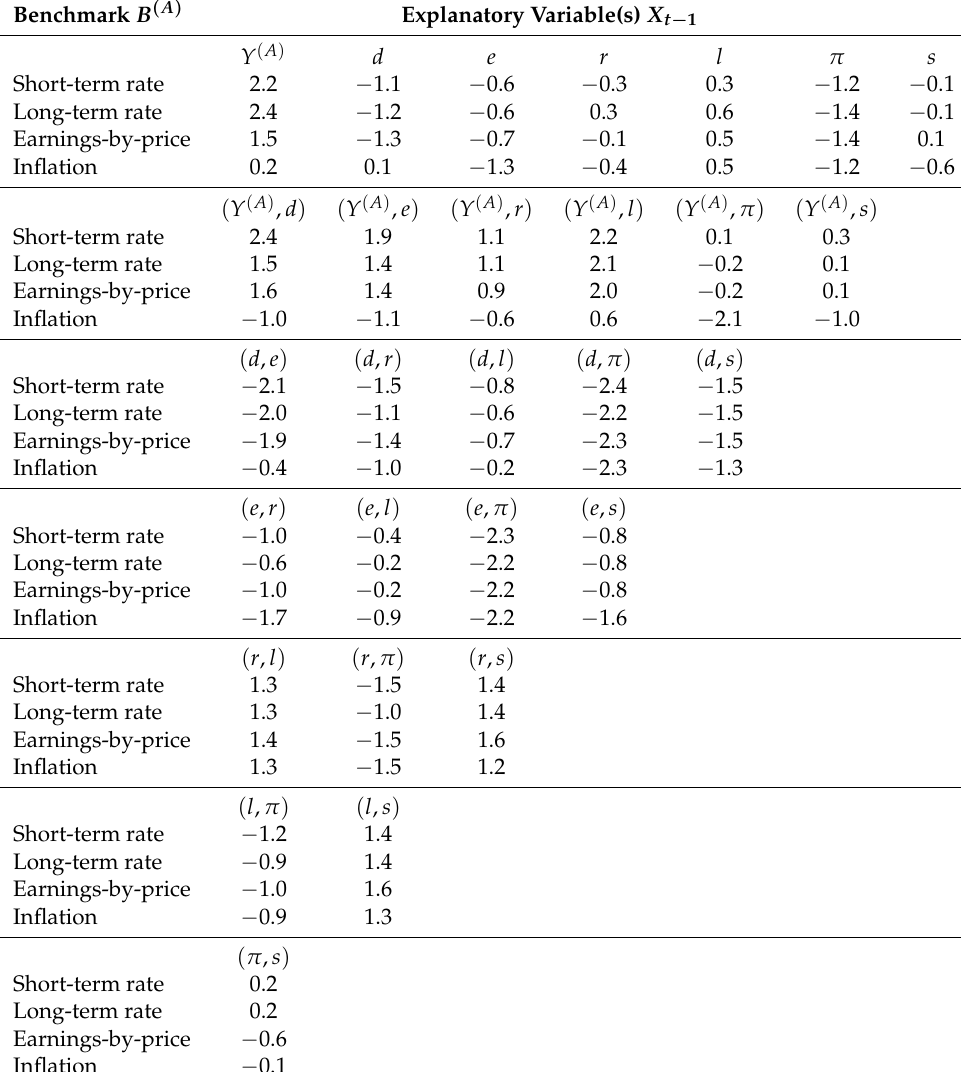
( A ) Table 2. Predictive power for the variance of one-year excess stock returns Y : the single t benchmarking approach. The prediction problem is defined in (2). The same predictive variables X t − 1 are used in the predictions for the conditional mean and variance function. The predictive power (%) is measured by R 2 as defined in (8). The benchmarks B ( A ) considered are based on the short-term V , ν interest rate ( A ≡ R ), long-term interest rate ( A ≡ L ), earnings-by-price ratio ( A ≡ E ), and consumer price index ( A ≡ C ). The predictive variables used are X t − 1 , given by the dividend-by-price ratio d t − 1 , earnings-by-price ratio e t − 1 , short-term interest rate r t − 1 , long-term interest rate l t − 1 , inflation π t − 1 , ( A ) term spread s t − 1 , excess stock return Y , or the possible different pairwise combinations as t − 1